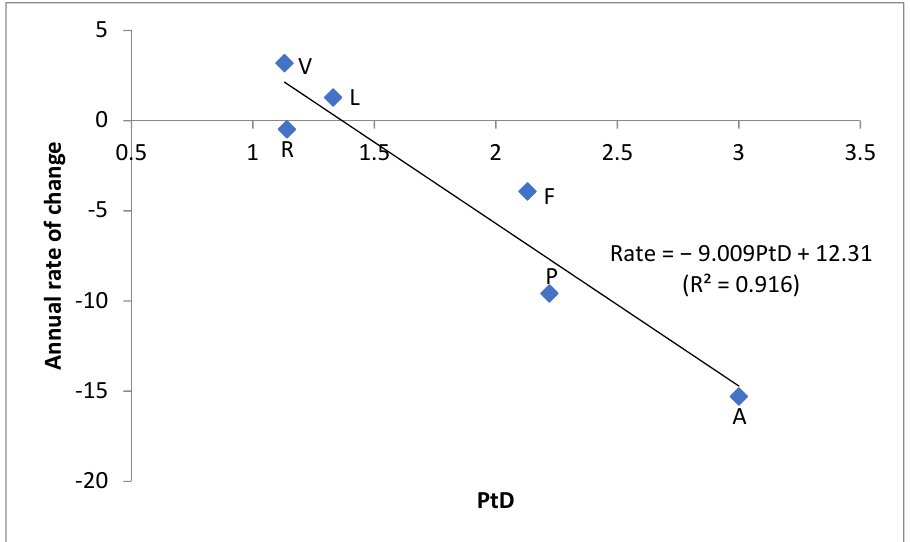
Figure 3. Regression relationship between the annual rate [(Area 2013 –Area 1990 )/(2013–1990), unit: km 2 per annum] of swampy meadow change during 1990–2013 derived from satellite images [22] and the derived propensity for degradation. A-alpine; F-floodplain; L-lacustrine; P-piedmont, R-riverine; V-valley (the same in Figures 4 and 5).